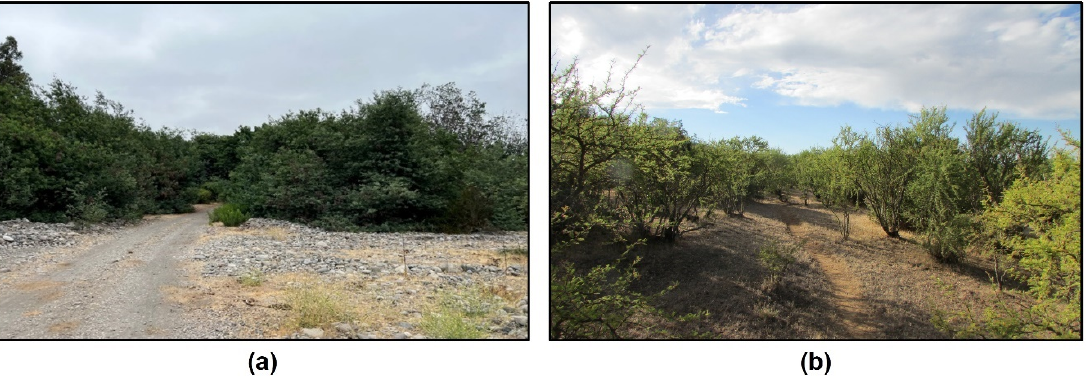
Figure 9. ( a ) Acacia dealbata specimens in the channel in Section 3, ( b ) Acacia caven , in the study